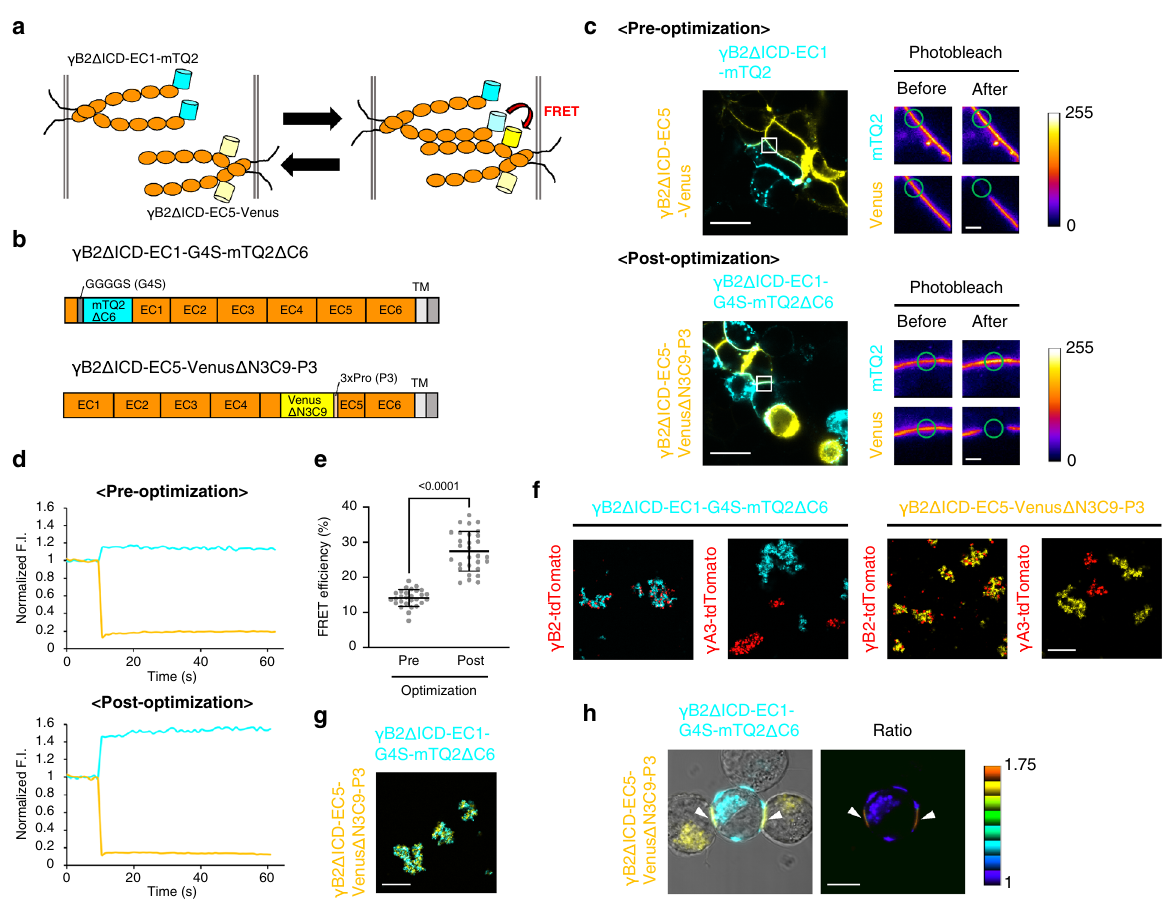
Figure 2. The γB2 trans interaction monitored by FRET-based γB2 indicators. ( a ) Schematics of the γB2 trans interaction, as visualized using the FRET-based γB2 indicators. The orange ovals represent the EC domains of γB2. mTQ2 and Venus are represented as cyan and yellow cylinders, respectively. ( b ) Schematics of linker- optimized FRET-based γB2 indicators. The C-terminal 6 amino acids of mTQ2 are deleted, and a GGGGS (G4S) linker is inserted at the N-terminus of mTQ2 in γB2ΔICD-EC1-G4S-mTQ2ΔC6. The 3 N-terminal amino acids and the 9 C-terminal amino acids of Venus are deleted, and a 3xPro (P3) linker is inserted at the C-terminus of Venus in γB2ΔICD-EC5-VenusΔN3C9-P3. ( c ) Representative acceptor photobleaching experiments of the pre- and post-optimized FRET-based γB2ΔICD indicators in HEK293T cells. HEK293T cells individually expressing the indicated constructs were co-cultured (left panels). The panels on the right represent magnified fluorescence images of white squared regions in left panels before and after acceptor photobleaching at green circles. The color bars indicate the range of the fluorescence intensities of mTQ2 and Venus (arbitrary units). Scale bars, 20 μm (left panel) and 2 μm (right panel). ( d ) Alterations in fluorescence intensities of mTQ2 and Venus by acceptor photobleaching in ( c ) were followed and plotted over time. ( e ) Mean values of FRET efficiency for the pre- and post-optimized FRET-based γB2ΔICD indicators (Pre, n = 28; Post, n = 29). Data are shown as the means ± SD. Significant difference was analyzed by Welch’s t test. p value is described in the graph. ( f ) Binding specificity of the FRET-based γB2ΔICD indicators by cell aggregation assay. K562 cells individually expressing the indicated constructs were co-cultured. Scale bar, 200 μm. ( g ) The interaction between γB2ΔICD-EC1- mTQ2ΔC6 and γB2ΔICD-EC5-VenusΔN3C9-P3, as revealed by cell aggregation assay. K562 cells individually expressing the indicated constructs were co-cultured. Scale bar, 200 μm. ( h ) Direct visualization of the γB2 trans interaction using the FRET-based γB2ΔICD indicators. K562 cells individually expressing the indicated constructs were co-cultured. The merged fluorescence and DIC image is shown in the left panel. The ratio image of Venus/mTQ2 is shown as intensity-modulated display (IMD) in the right panel. Scale bar, 10